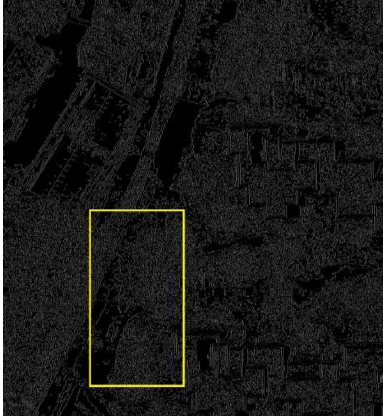
Figure 1. This figure depicts the test area captured in aerial image.